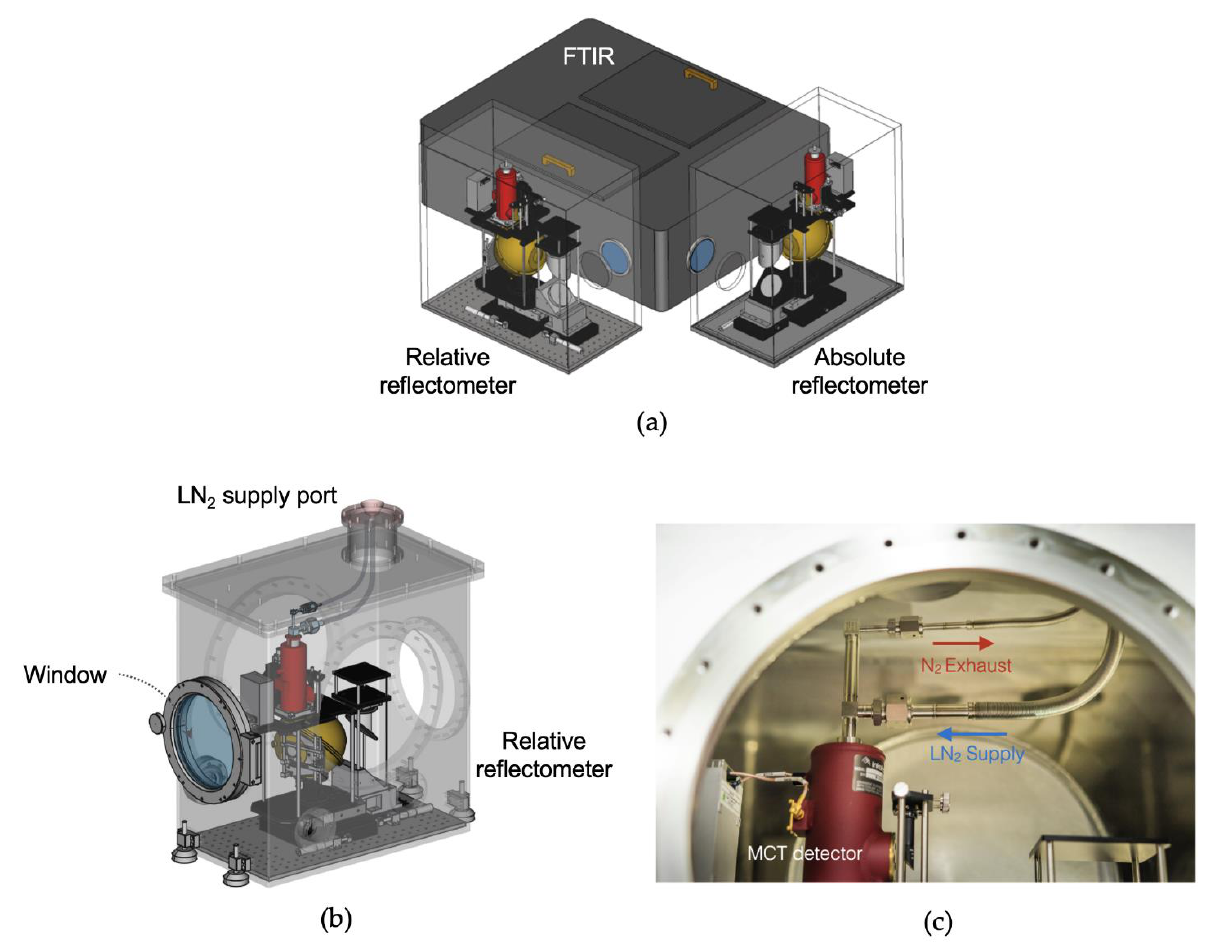
Figure 5. ( a ) Perspective schematic of the reflectometer in the vacuum chamber. ( b ) Schematic of the absolute reflectometer in the vacuum. ( c ) Liquid nitrogen (LN 2 ) supply and nitrogen (N 2 ) gas exhaust system for the MCT detector.